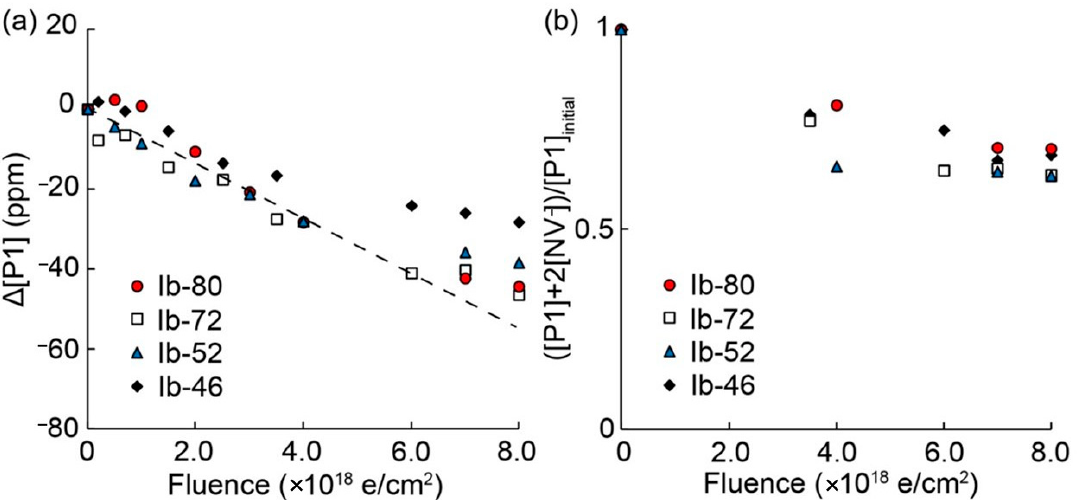
Figure 6. Conversion from P1 center to NV − center. ( a ) Irradiation fluence dependence of Δ [P1] (changes from the [P1] initial ). Broken line is for visual guide. ( b ) Irradiation fluence dependence of value of ([P1] + 2[NV − ])/[P1] initial . Ib-80 (closed red circles), Ib-72 (open black circles), Ib-52 (closed blue circles), Ib-46 (closed black circles),